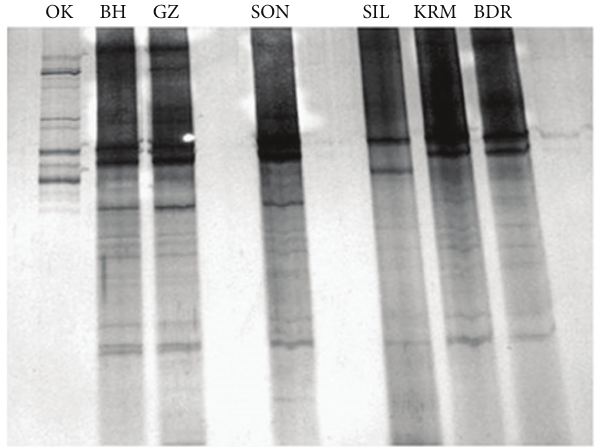
Figure 2: Community profiling of methanogens using 16s rDNA basedonDGGE:thecommunityprofilingofmethanogenicdiversity present in the leachate sample of Delhi landfill site (OK, BH, and GZ) and marshland sample of Southern Assam (SON, SIL, KRM, and